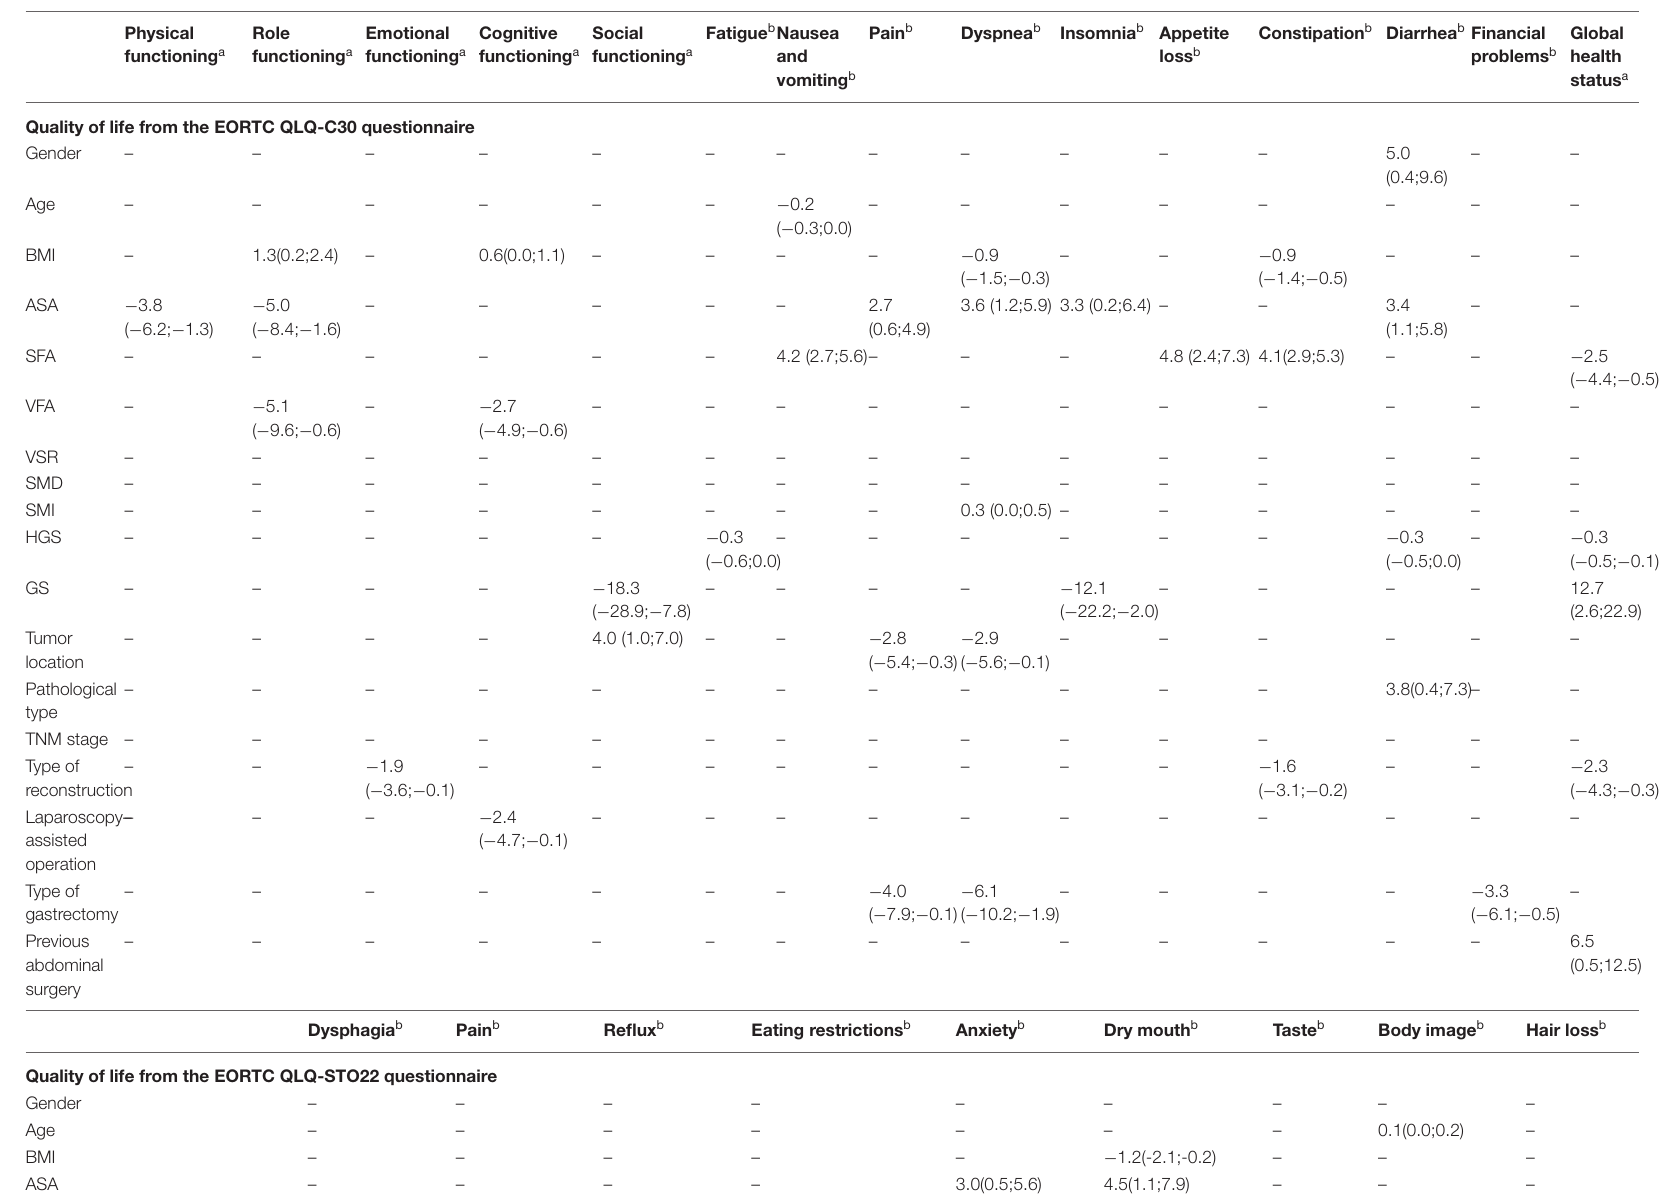
TABLE 3 | Multivariable linear regression model on quality of life, symptom scales, and functional scales from EORTC QLQ-C30 and QLQ-STO22 for 1 month after